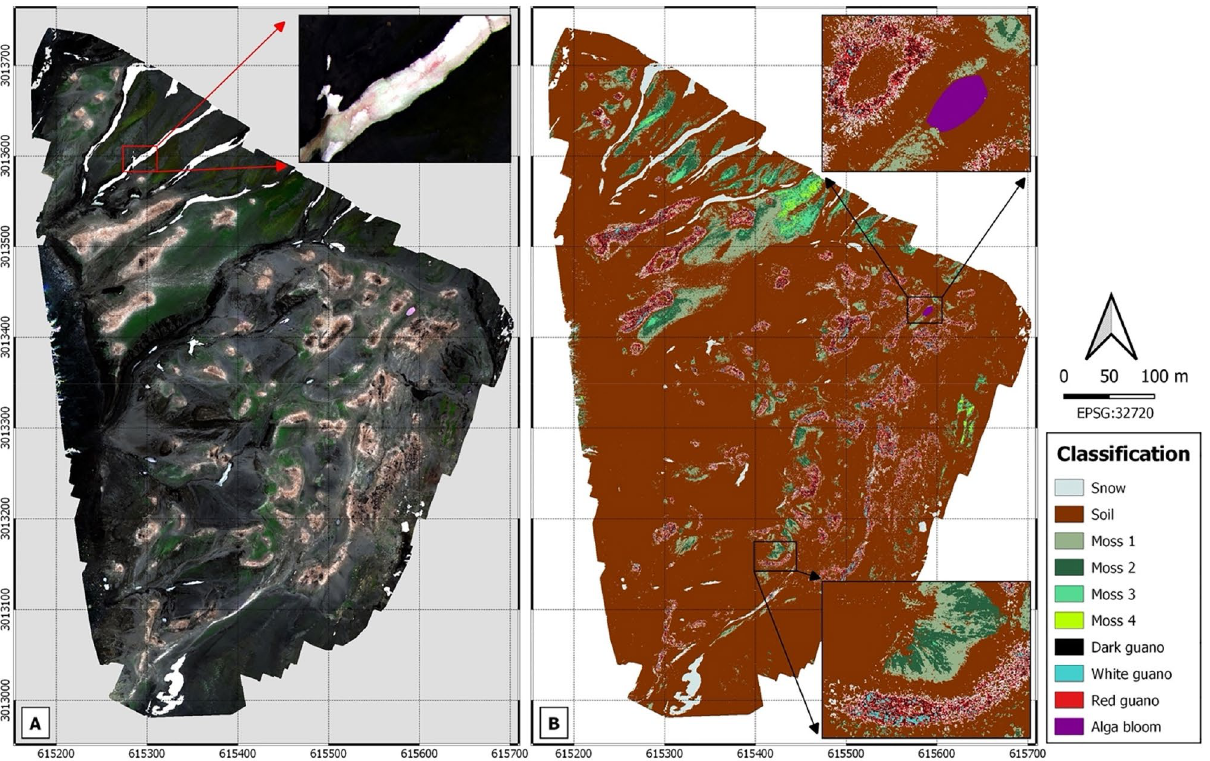
Figure 1. Photomosaics of Vapour Col Chinstrap penguin colony on Deception Island composed of 3800 pictures taken at 100 m altitude with a 10 bands multispectral camera onboard a hexacopter, achieving 6 cm/ pixel size. Panel ( A ): visible RGB mosaic (Red-668, Green-560 and Blue-475) with a zoom capture showing red snow patch; Panel ( B ): thematic map generated through non-supervised classification